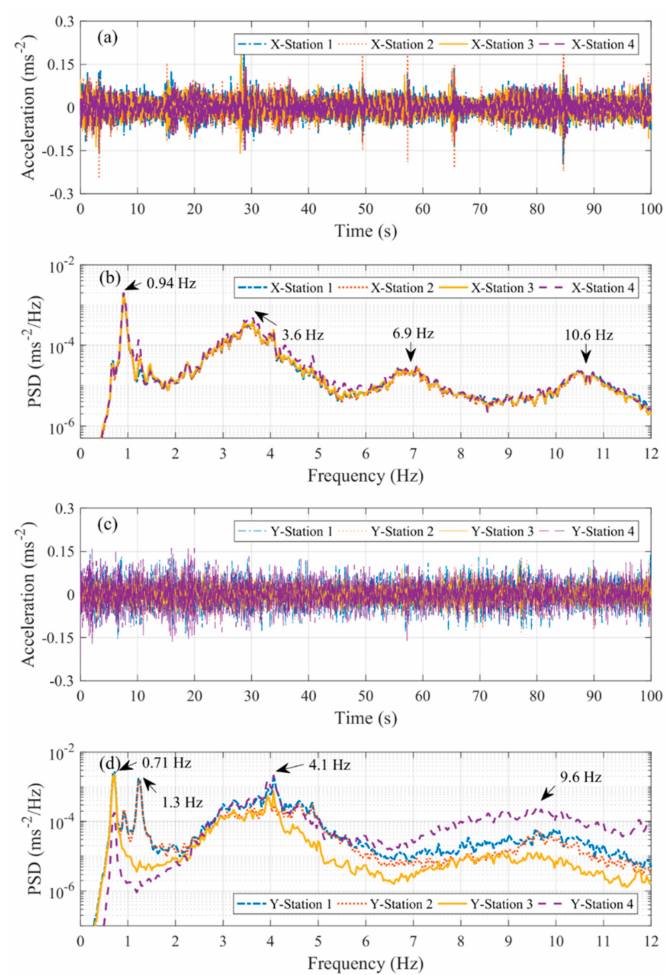
Figure 2. Ambient responses of the #6 building’s roof: ( a ) time histories along the X-direction; ( b ) power spectrum density (PSD) along the X-direction; ( c ) time histories along the Y-direction; ( d ) PSD along the Y-direction.